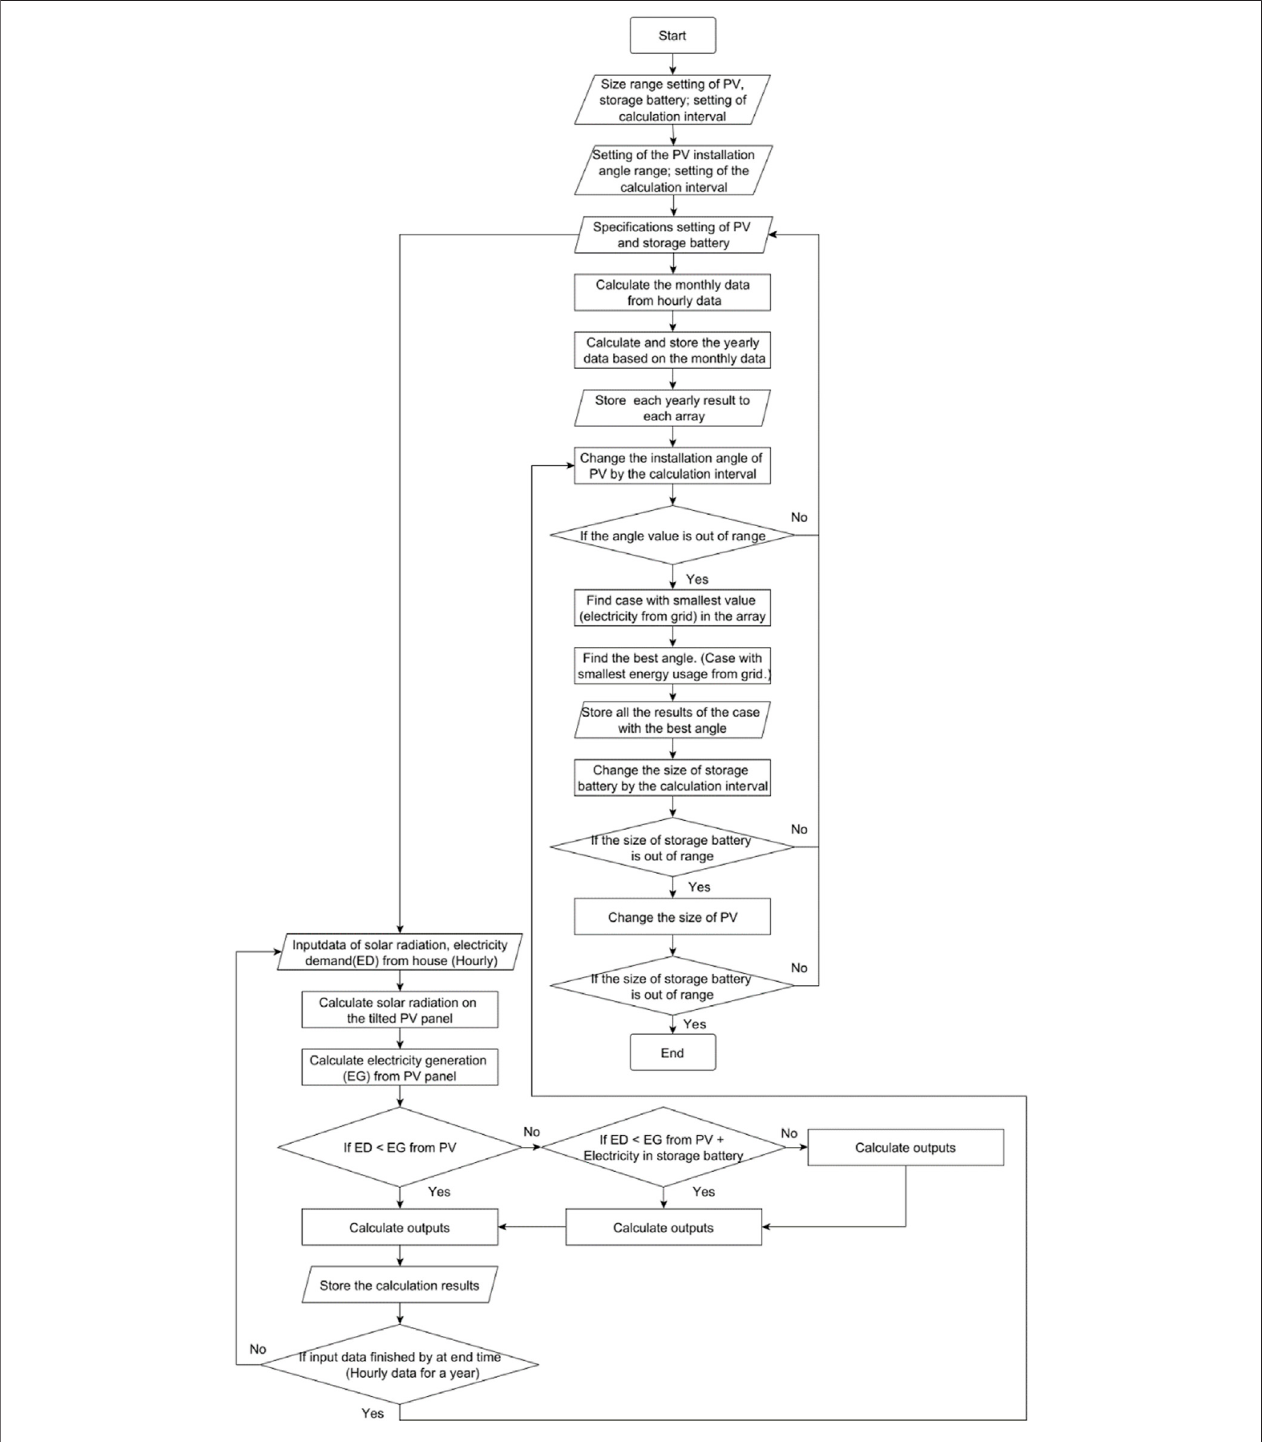
FIGURE 4 | Calculation fl owchart of the nonlinear